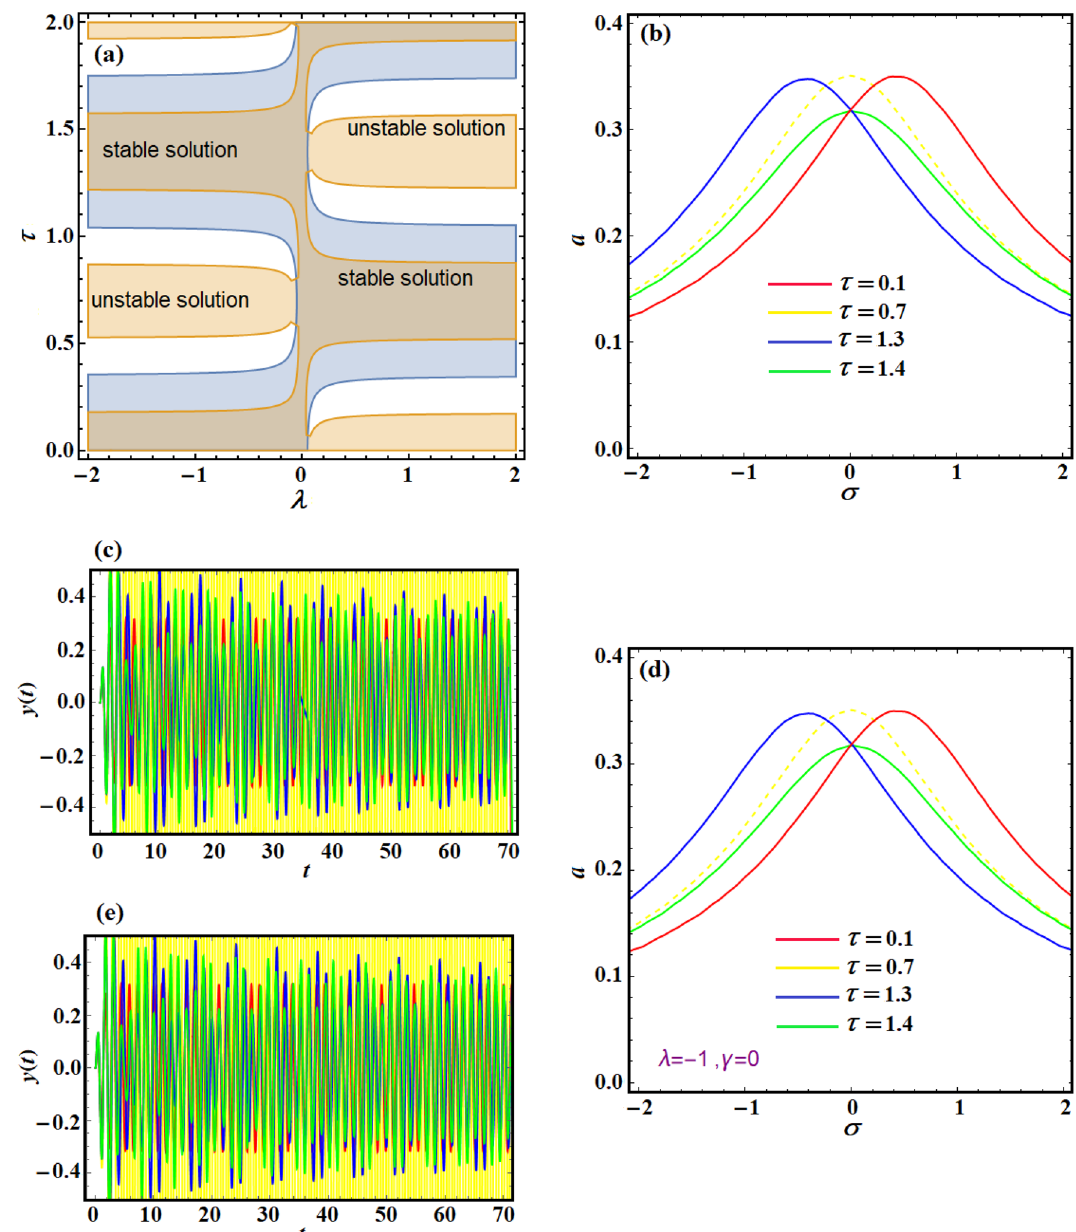
Figure 11. ( a ) Shows the stable and unstable solution zone in ( (cid:31) − τ) plane when σ = γ = 0 , ( b ) describes the frequency–response curves of the system at (cid:31) = − 0.1, γ = 0, F = 3 for different values of the time-delay parameter, ( c ) explores the system time response when τ( = 0.1, 0.7, 1.3, 1.4 ) , ( d ) reveals the system frequency– response curves at (cid:31) = 0.2, γ = 0, F = 2.5 for various values of time-delay parameter, and ( e ) shows the system time response at τ( = 0.1, 0.7, 1.3, 1.4 )